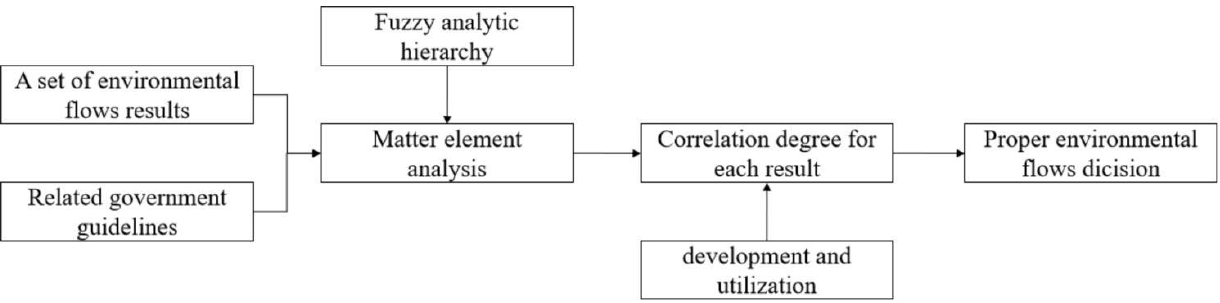
Figure 2. Conceptual framework of DSE model for e-flows.